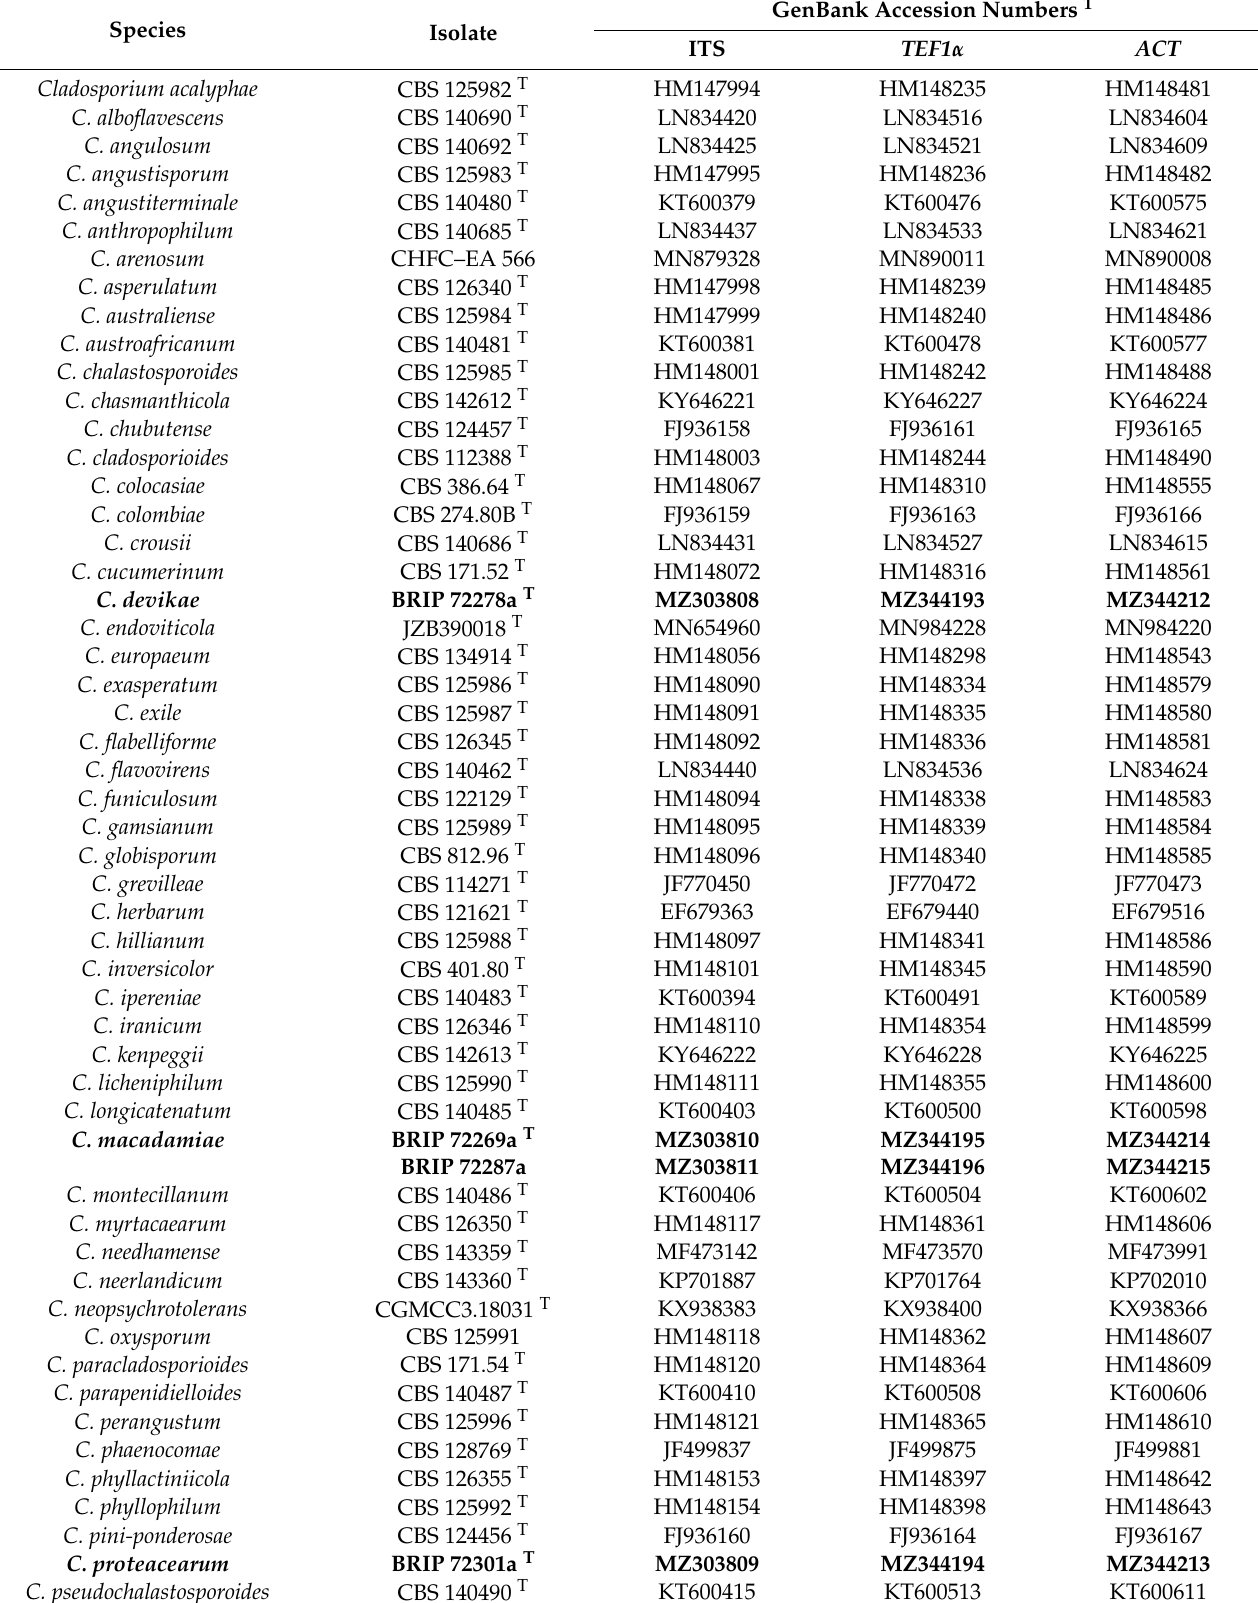
Table 3. Cladosporium species and isolates used in the phylogenetic analysis with GenBank accession numbers. Species